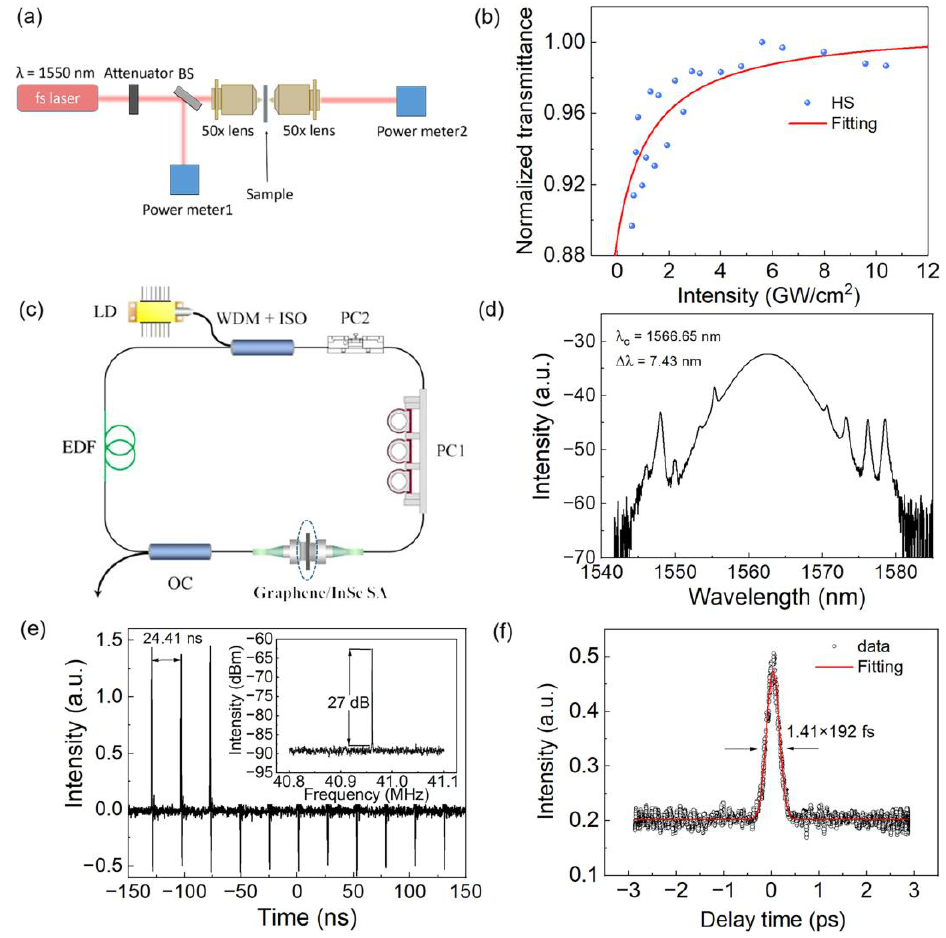
Figure 4. ( a ) Schematic diagram of the micro I-scan measurement system. ( b ) Nonlinear saturable absorption curve of G/InSe HS. ( c ) Schematics of the mode-locked fiber laser based on G/InSe HS SA. ( d ) Output optical spectrum based on G/InSe HS SA (the spectral resolution is 0.02 nm). ( e ) Mode-locked pulse trains. Inset figure is the obtained RF spectrum with 100 Hz resolution bandwidth. ( f ) AC trace of mode-locked pulses after amplification and compression.